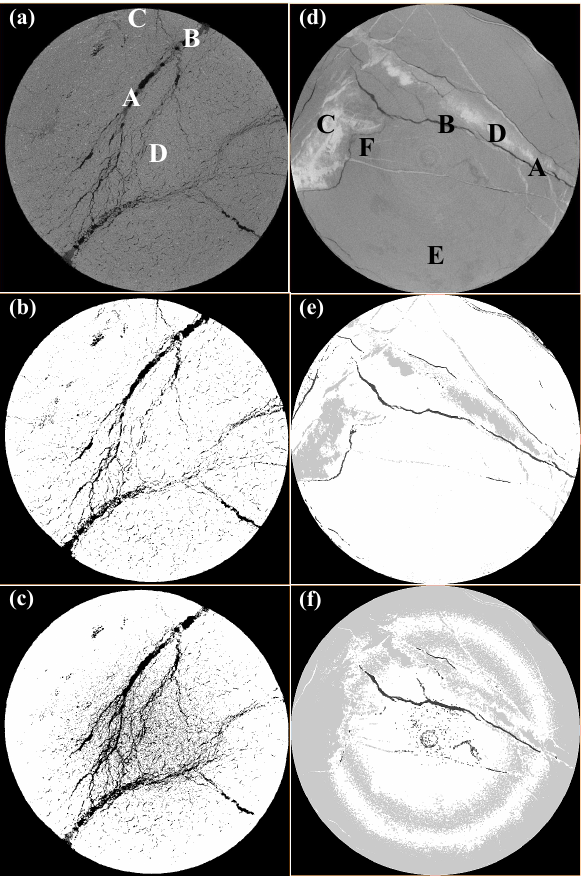
Figure 6. Pixel-based image classification using LS-SVM, where (a) and (d) depict locations of pixels selected for training in the original µ XCT image, (b) and (e) the output of the multi- classification on the BH-corrected image, (c) and (f) the output of multi-classification in the presence of BH artefacts. In im- age (b) and (c) , the dark colour represents cracks/pores, while the light colour shows the clay mineral regions of sample A; in im- ages (e) and (f) , the dark colour represents the halite veins, grey colour the anhydride phase, and light colour the clay mineral region of the evaporite rock cores B and